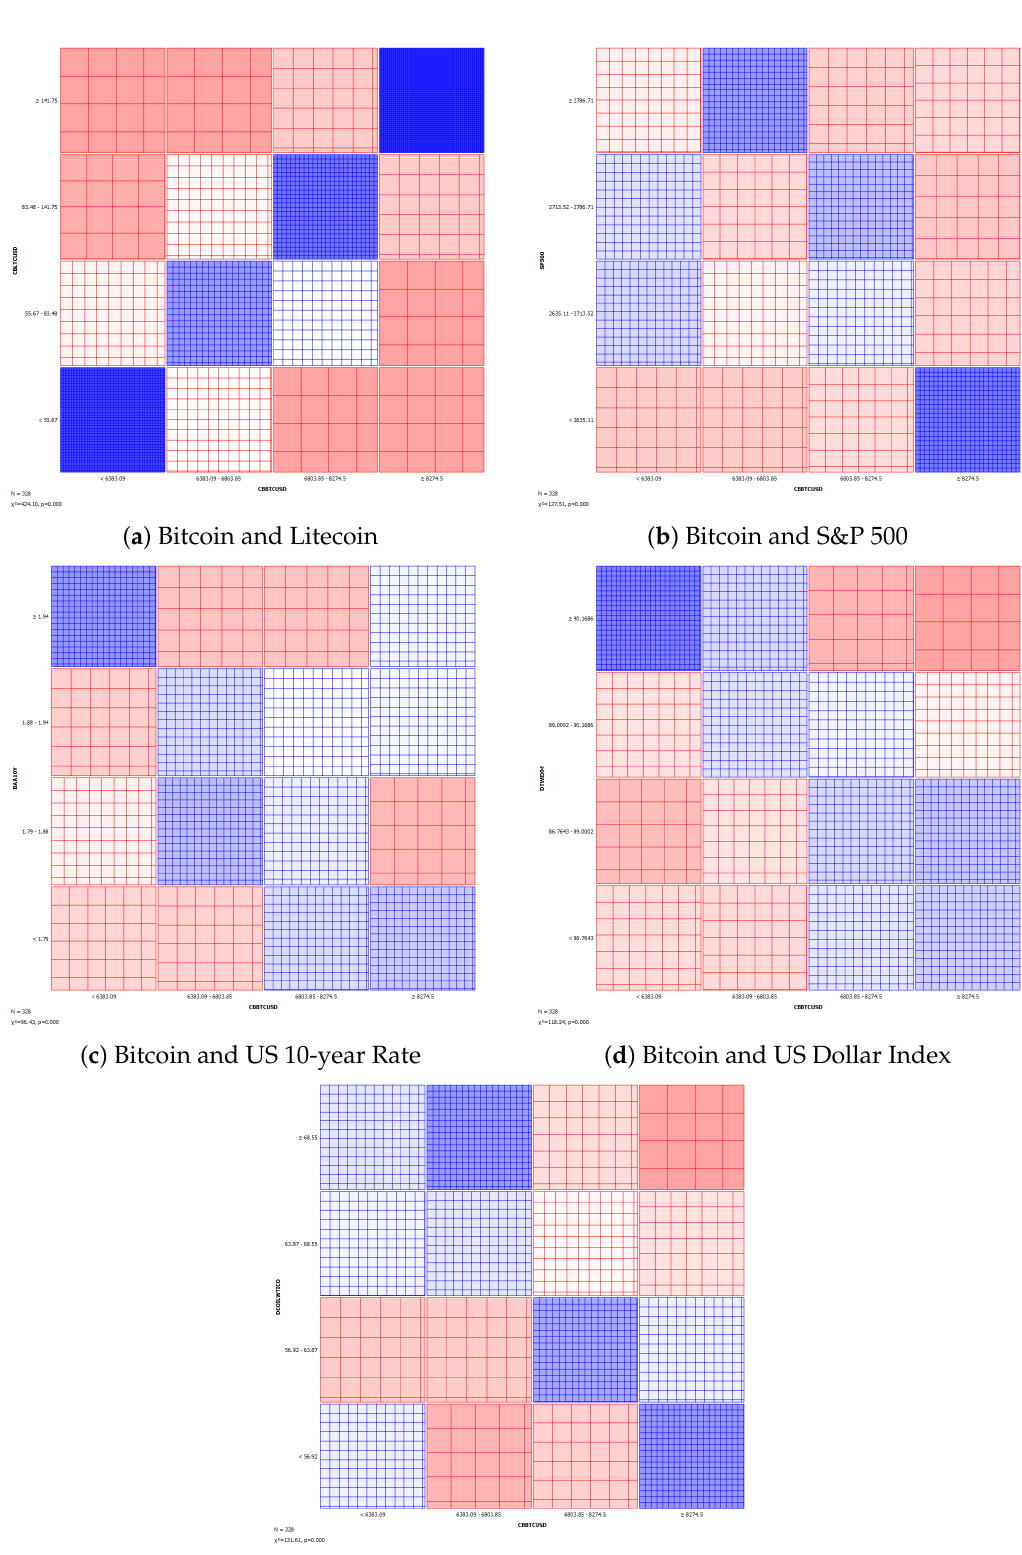
Figure 5. Sieve diagrams between Bitcoin spot and other assets. Note: In Sieve or ‘parquet’ diagrams, the area of each rectangle is proportional to the expected frequency, while the observed frequency is shown by the number of squares in each rectangle. The difference between observed and expected frequency (proportional to the standard Pearson residual) appears as the density of shading, using color to indicate whether the deviation from independence is positive (blue) or negative